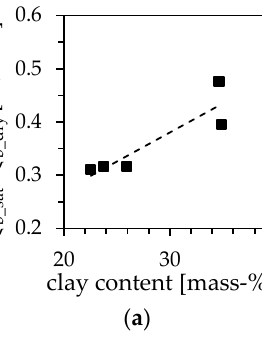
Figure 7. ( a ) Correlation of the difference of ρ b_sat and the bulk density after oven drying ( ρ b_dry ) with clay content; ( b ) correlation of the difference between the initial bulk density ( ρ b_ini ) and the density after saturation ( ρ b_sat ) with ρ b_ini . The differences were calculated with the actual measured bulk densities and not with the rough indication of Table 7.